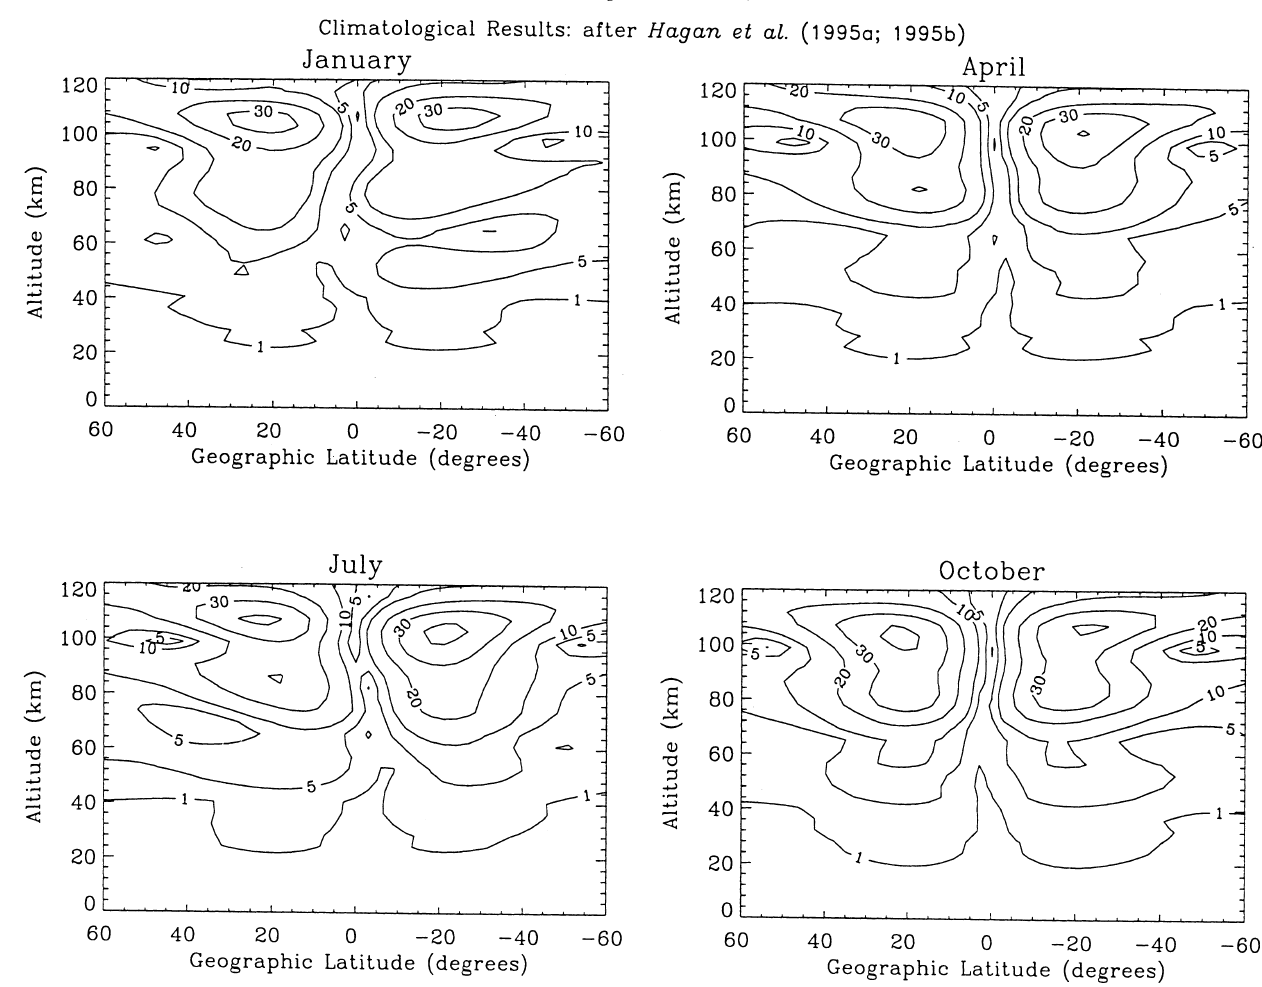
Fig. 2. Meridional wind amplitudes (m s ) 1 ) from calculations for the diurnal tide of Hagan et al